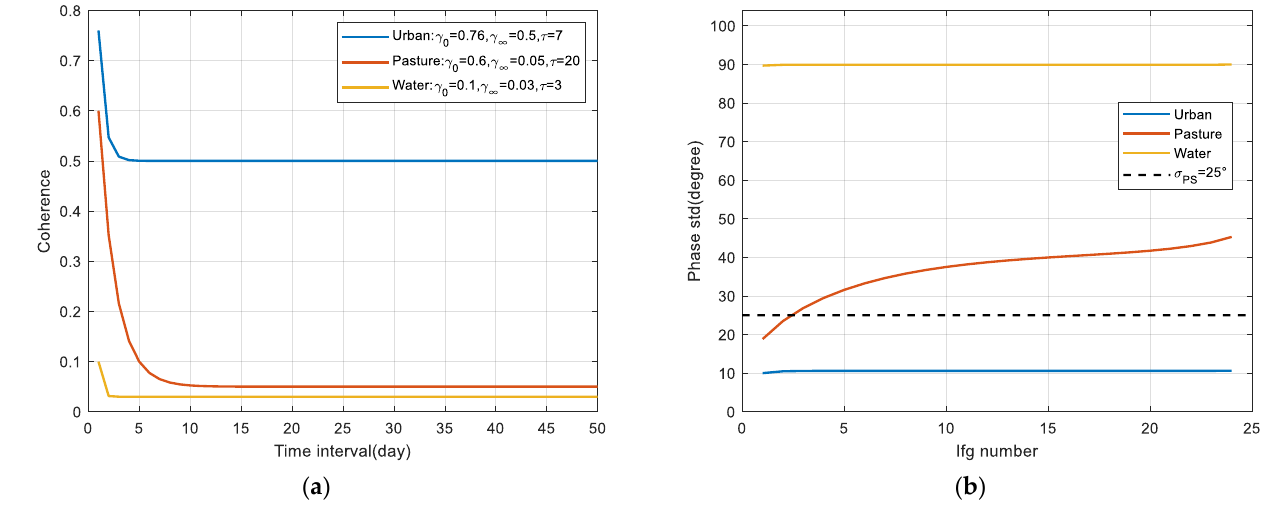
Figure 1. Temporal coherence and CRB of the preprocessed phase of DSs. ( a ) Temporal coherence model in urban, pasture, and water areas; ( b ) The CRB standard deviations of the preprocessed phase of DSs and the standard deviation of a typical PS ( ∼25° ) are also plotted.